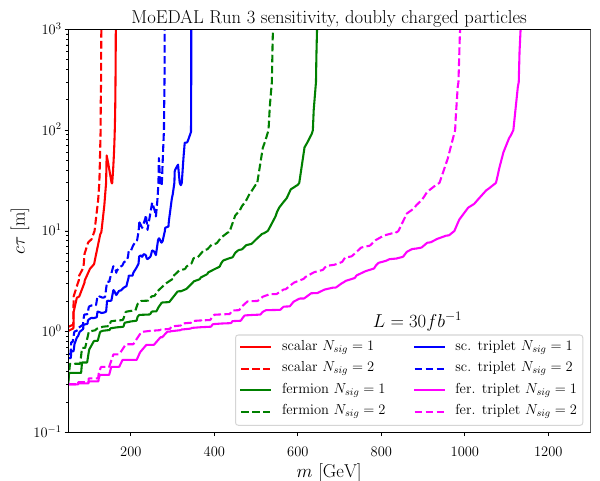
Fig. 5 The expected sensitivities of MoEDAL for various long-lived doubly-charged particle species, assuming 30 fb − 1 of integrated lumi- nosity